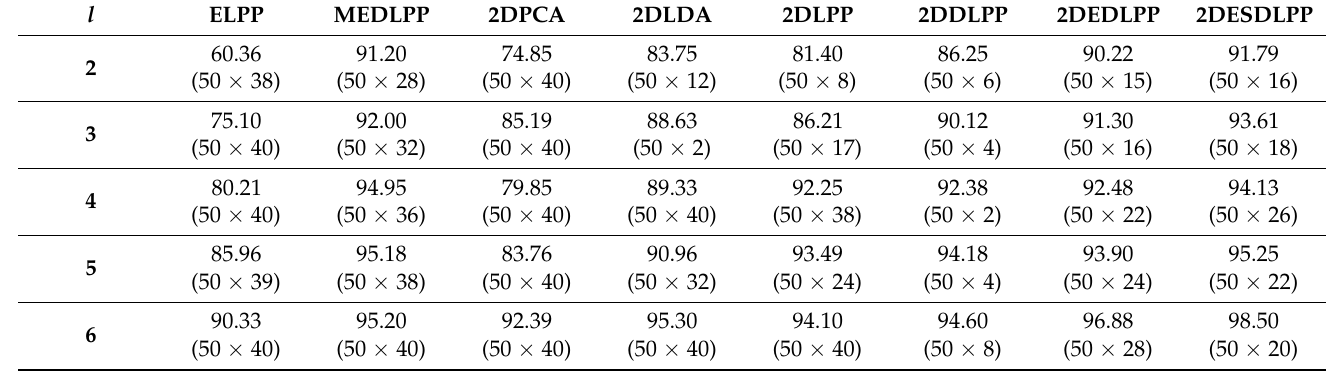
Table 2. Maximum average recognition rate (%) of 2DESDLPP and other seven comparison algorithms and the corresponding number of dimensions in the ORL database.